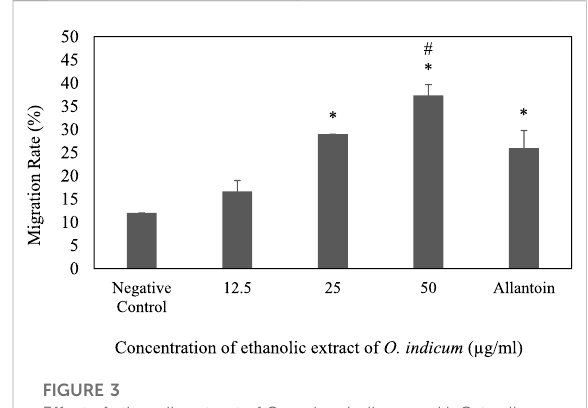
FIGURE 3 Effectofethanolicextractof Oroxylumindicum onHaCatcell migration.Resultsaremean±SD( n =3).Thesymbol*denotesthe signi fi cantly( p < 0.05)differencebetweenthetreatedandnegative controls. The symbol # denotes the values are signi fi cantly ( p < 0.05) different from the positive control